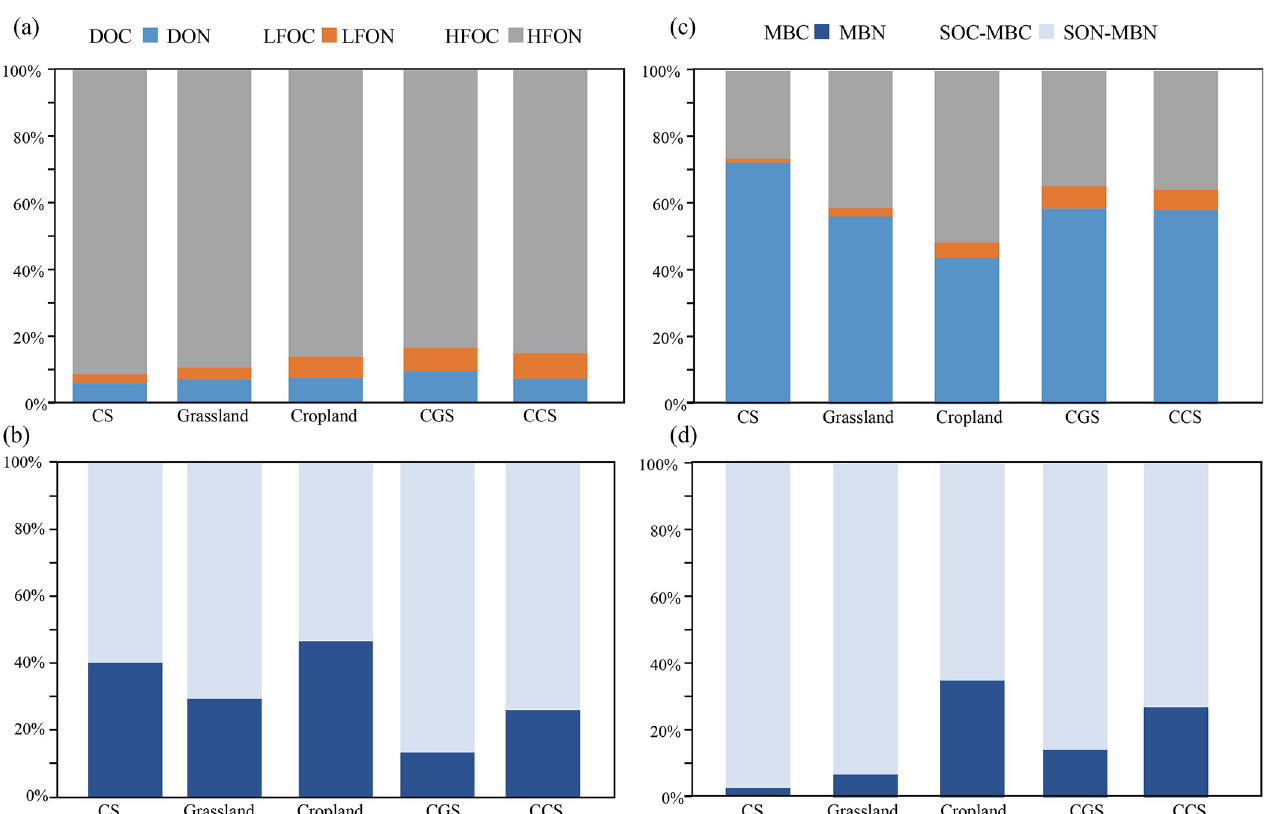
Fig 6. Proportions of C fractions and N fractions. The (a) showed proportions of DOC, LFOC, HFOC; (b) showed proportions of MBC and other organic carbon; (c) showed proportions of DON, LFON, HFON; (d) showed proportions of MBN and other organic nitrogen.